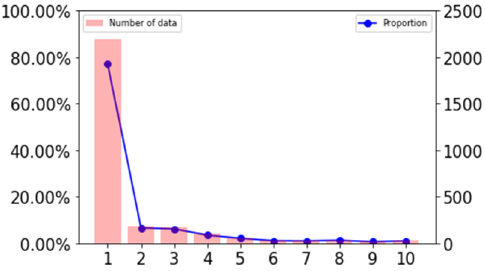
Figure 4. Missing duration distribution statistics.